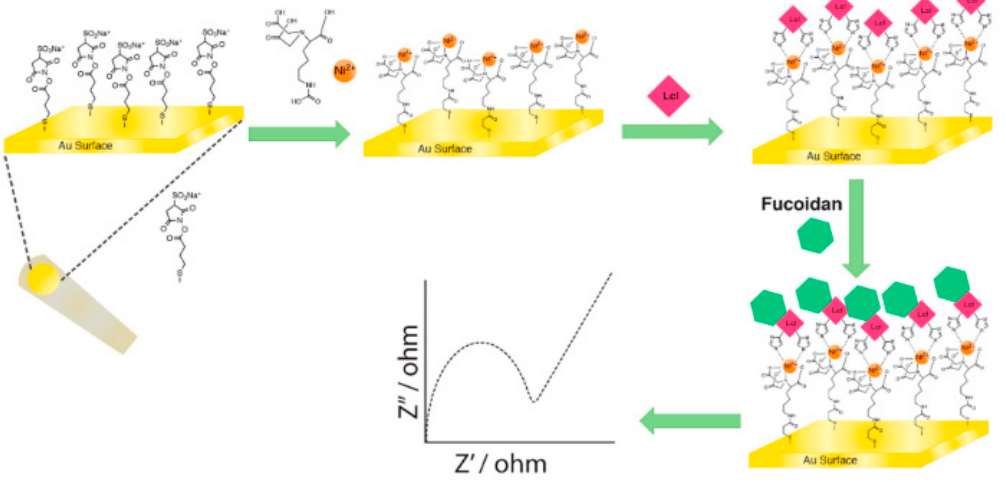
Figure 5. Illustrative representation of Lcl immobilization and fucoidan detection using EIS. A gold electrode was chemically modified after which nickel was electrostatically bound to the surface. This facilitated the binding of Legionella proteins, which were detected by electrochemical impedance spectroscopy (EIS). Reproduced with permission from [149] .